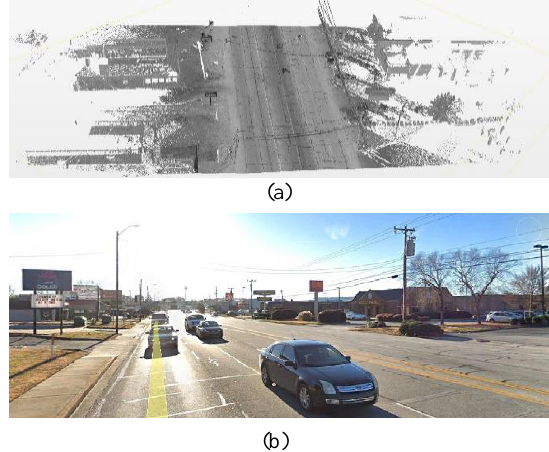
Figure 1. The selected test section from a 600 m dataset. (a) The selected point cloud; (b) Street view of test area from Google Maps, 2019.